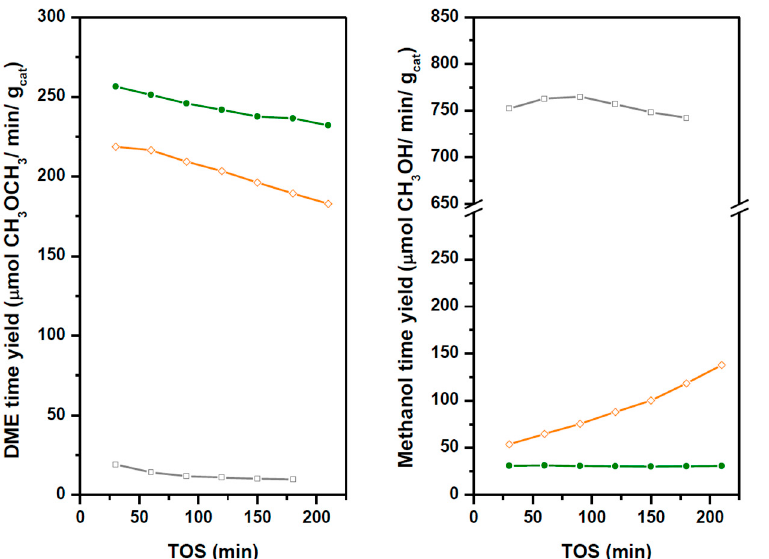
Figure 12. Methanol and DME time yield ( μ mol/min/g catalyst) from syngas over CZA-1.4HPW/Ti ( □ ), CZA-1.7HPW/Ti ( ◊ ) and CZA-2.7HPW/Ti ( ● ).